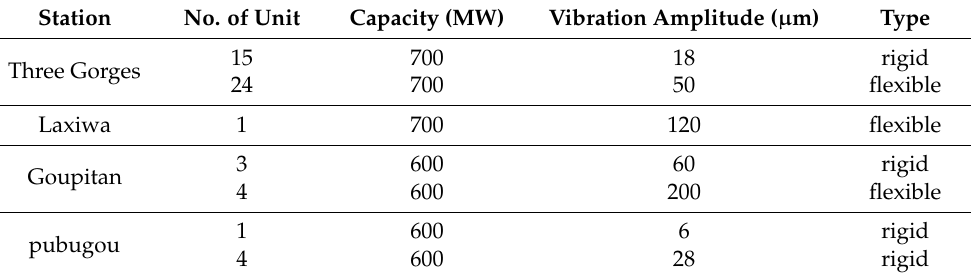
Table 6. Vibration data of stator frame of different